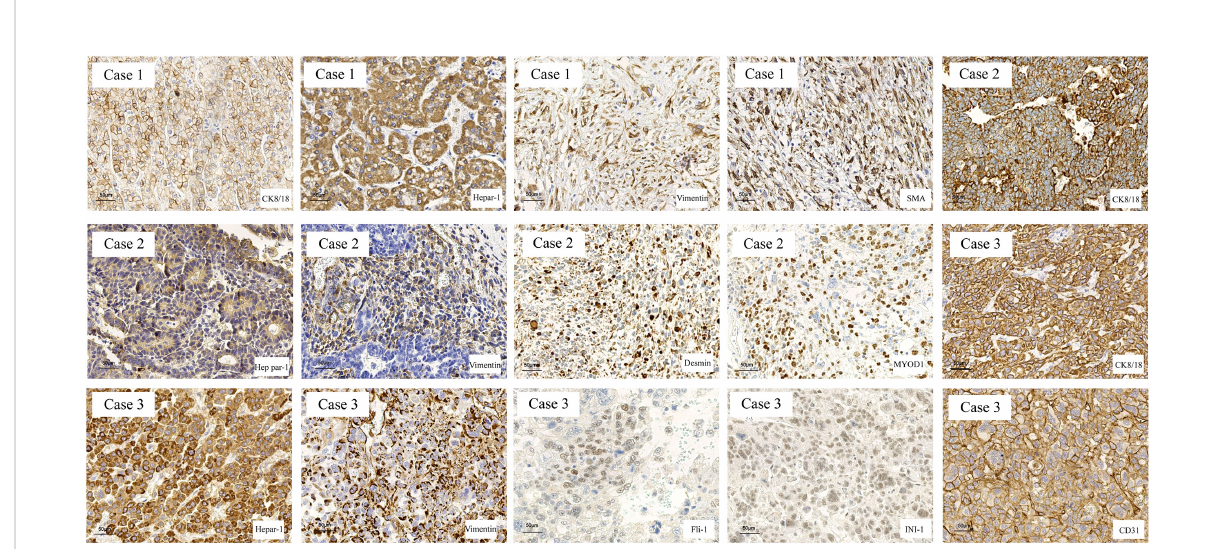
FIGURE 2 The markers of hepatocarcinoma and sarcoma were determined in HCS tissues by IHC. The hepatocarcinoma markers, including CK8/18 and Hep Par-1, were positive in the carcinomatous components, and the mesenchymal markers, including Vimentin, SMA, MYOD1, FLI-1, INI-1, and CD31, were used to determine the tissue source of the mesenchymal